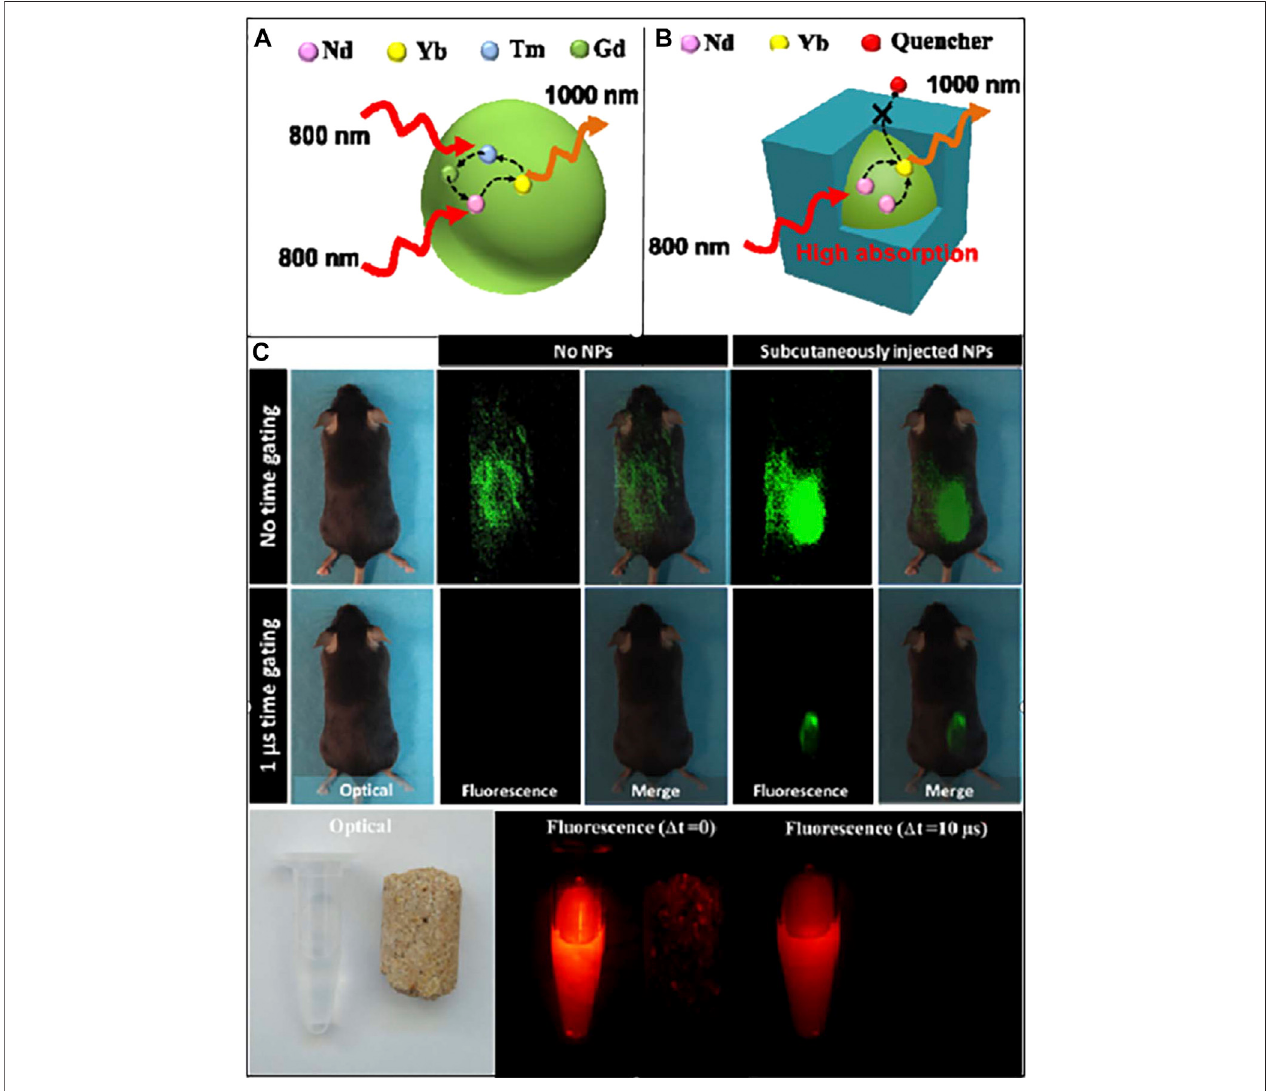
FIGURE6|(A) SchematicdiagramofenergytransferinNaYF4:Yb 3+ ,Nb 3+ ,andTm 3+ NPs, (B) thecore/shellstructureofNaYF4:Yb 3+ ,Nb 3+ @CaF 2 NPs, (C) optical and NIR images of C57BL/6 mice and NaYF4:Yb 3+ , Nb 3+ @CaF 2 (George et al.,